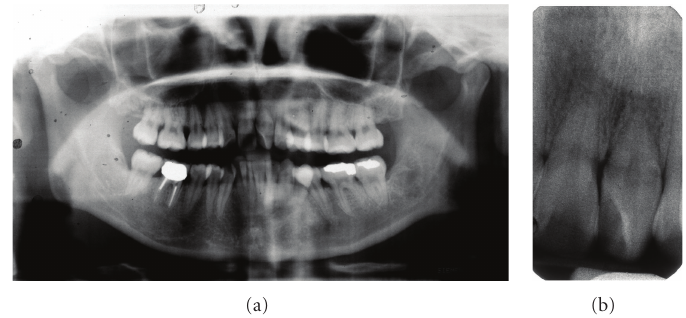
Figure 3: Pretreatment panoramic and periapical radiographs.